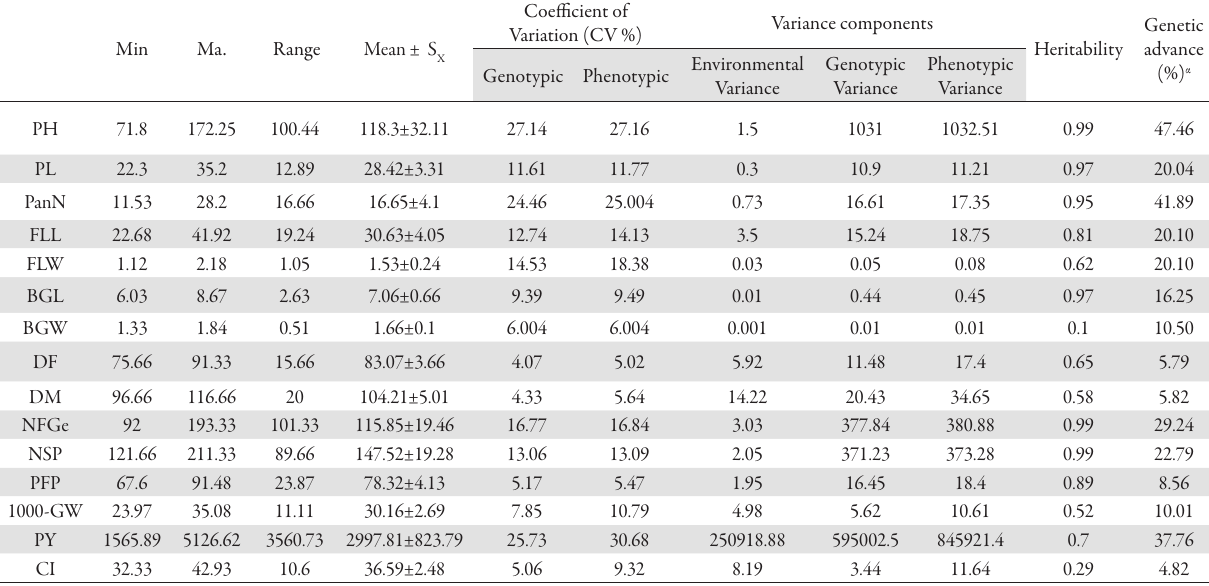
PH=Plant height (cm); PL=Panicle length (cm); PanN=Panicle number/plant; FLL=Flag leaf length(cm);FLW= Flag leaf width (cm); BGL= Brown grain length (mm); BGW= Brown grain width (mm); DF= Days to 50% flowering; DM= Days to complete maturity; NFG= Number of filled grains per panicle; NSP=Number of spikelet/panicle; PFP=Panicle fertility percentage;1000-GW= 1000-grain weight; PY=Paddy yield (kgha -1 );CI= Chlorophyll index; a Honestly Signification Different (Tukey’s test) at 5% probability level; b Least Significant Different at 5% probability level ; α Genetic advance with 10% selection intensity